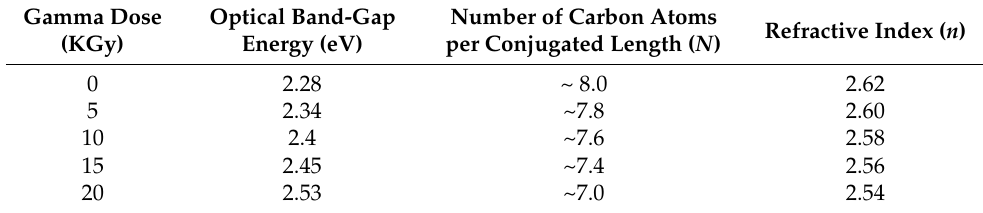
Table 1. The variation of optical energy band-gap ( E g ), the number of carbon atoms per conjugated length ( N ), and refractive index ( n ) for B-co-MP in THF at a concentration of 1 µ M at different gamma